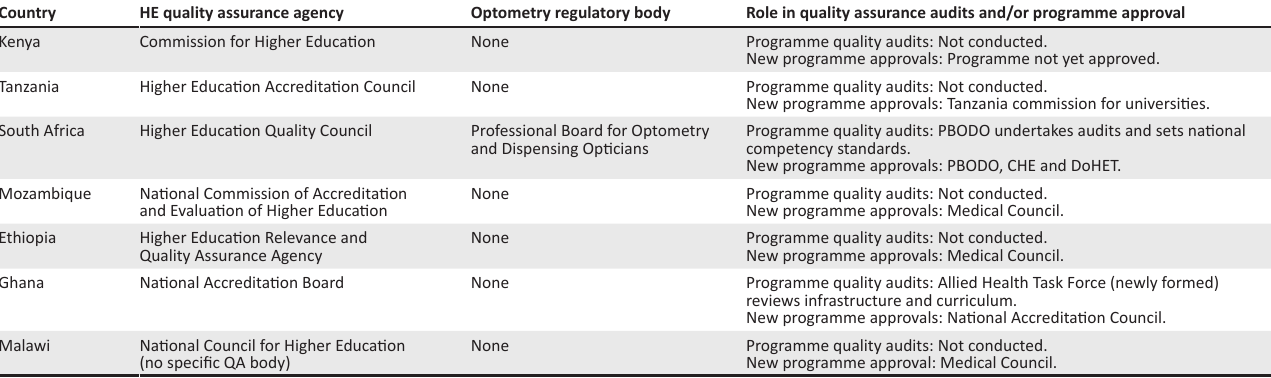
TABLE 1: The higher education quality assurance agencies in countries represented in this study, the respective optometry regulatory bodies and the roles of the regulatory organisations in quality assurance in optometry programmes.